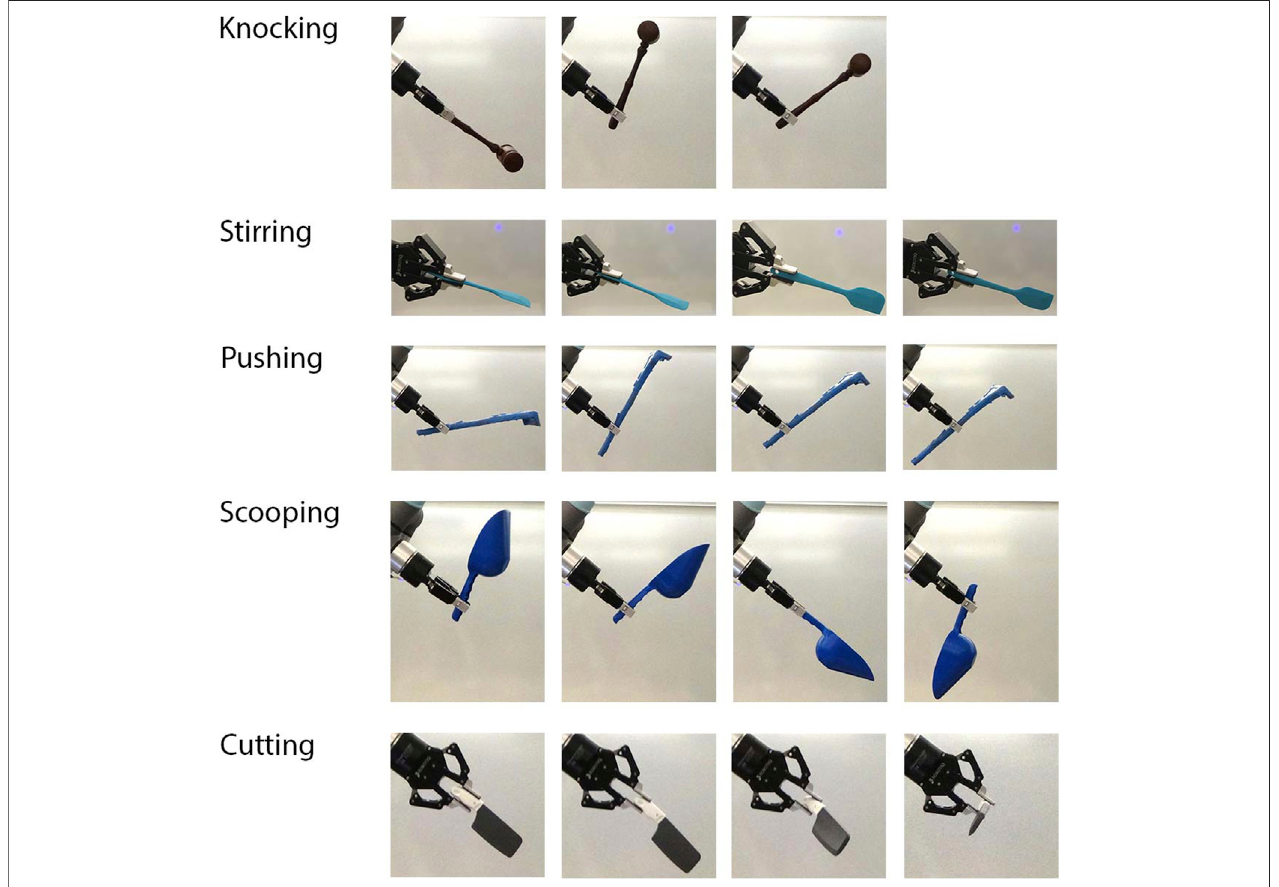
FIGURE 6 | Different grasping poses of the source tools (Star 1). For each task, that is, knocking, stirring, pushing, scooping, and cutting, at least three different grasping poses were tested.